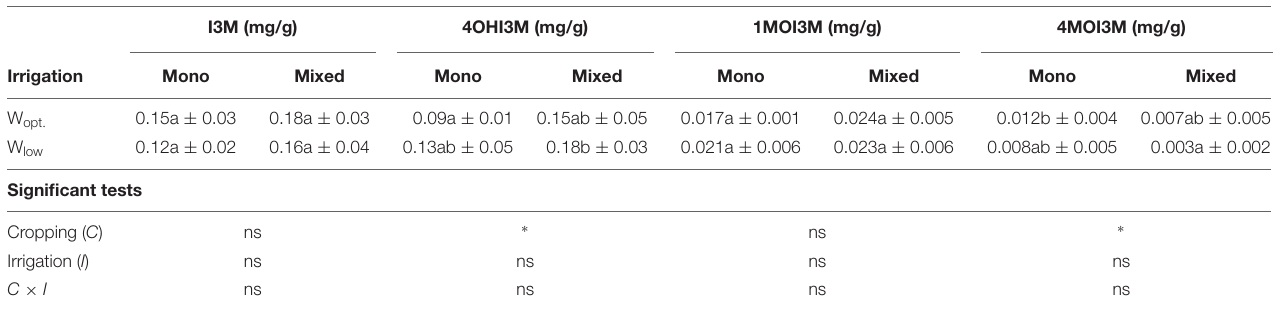
TABLE 3 | Indole glucosinolate concentration in B. carinata leaves at